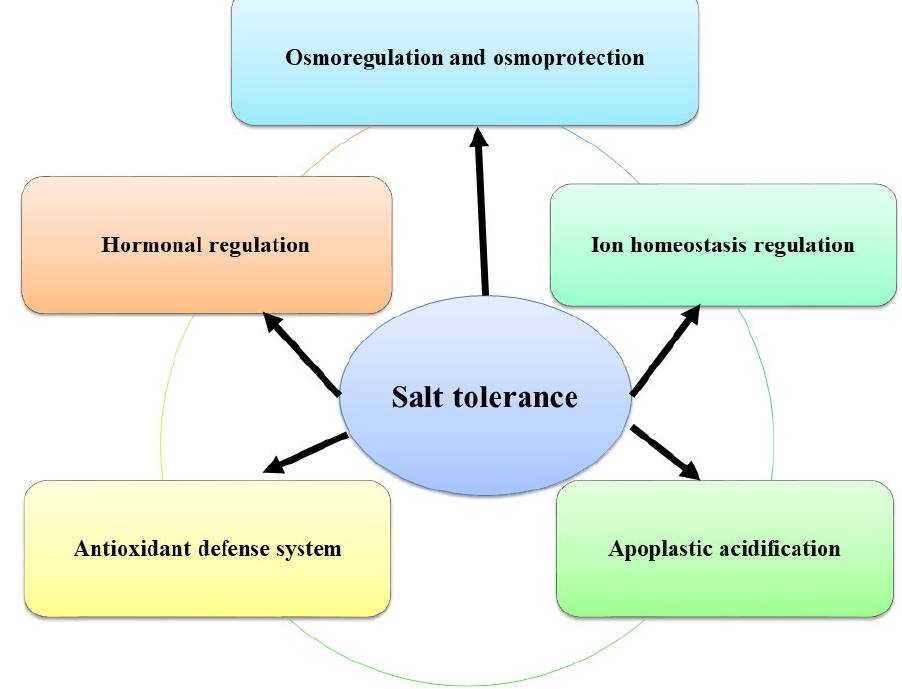
Figure 5. Mechanisms of Salt Tolerance in Plant.